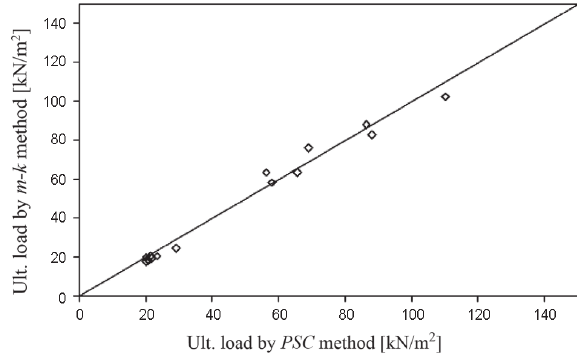
Fig. 13. Comparison of ultimate loads calculated using the m-k and the improved PSC